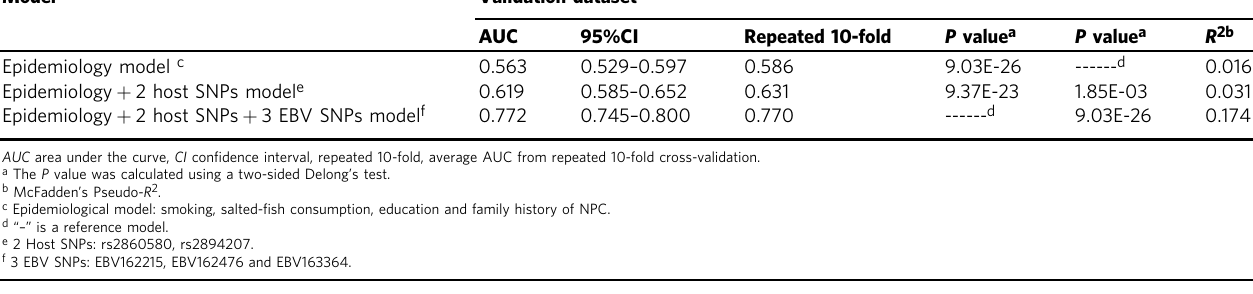
Table 2 The performance of the models for distinguishing the patients with NPC from the controls. Model